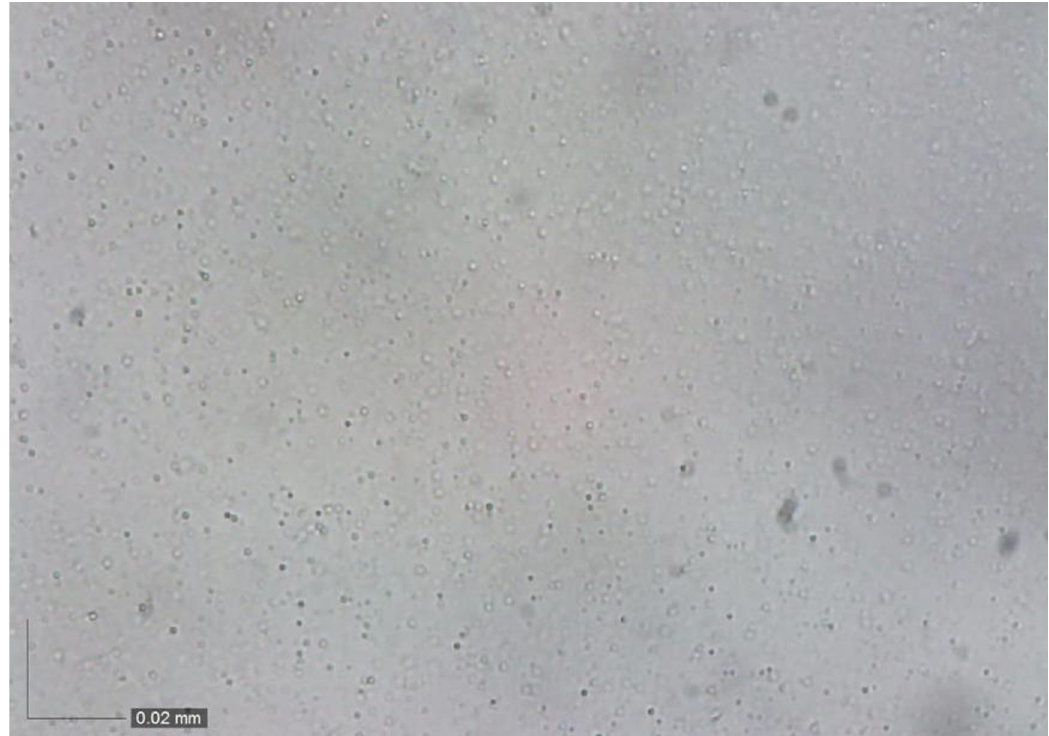
Fig 9. Optical microscopy image of crude O/W of the 7 th day.